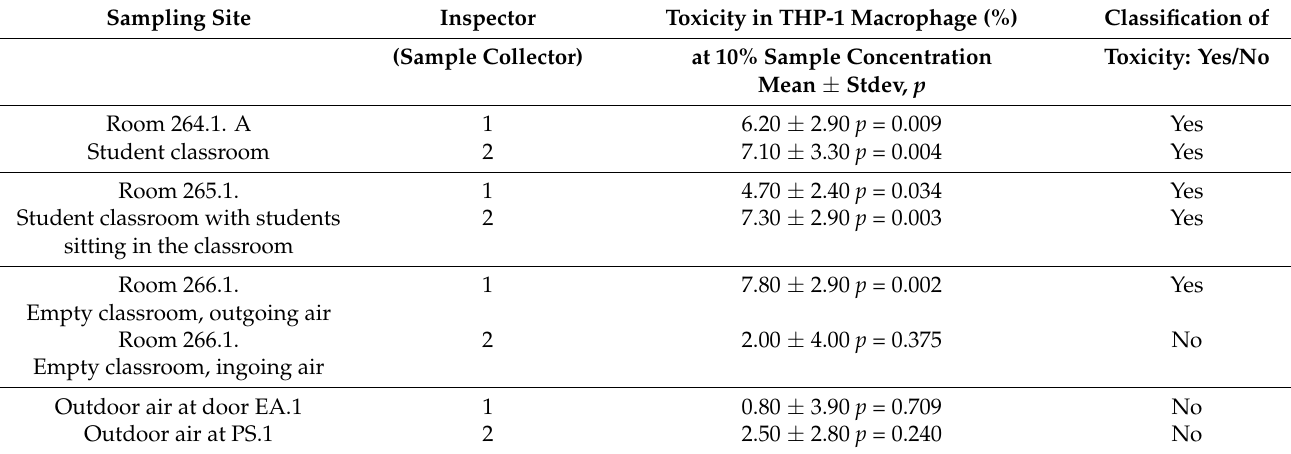
Table 3. Indoor air water samples from the target building. Samples were collected by two different building inspectors, 1 and 2. The difference between the results of Room 266.1 can be explained due to the different positions of the collector devices. Inspector 2 took samples close to the incoming air vent, whereas those from inspector 1 were close to the outgoing air vent. Results are provided as mean ± stdev; p < 0.05 means that the result is statistically significant; p > 0.05 means that the result is not statistically significant.